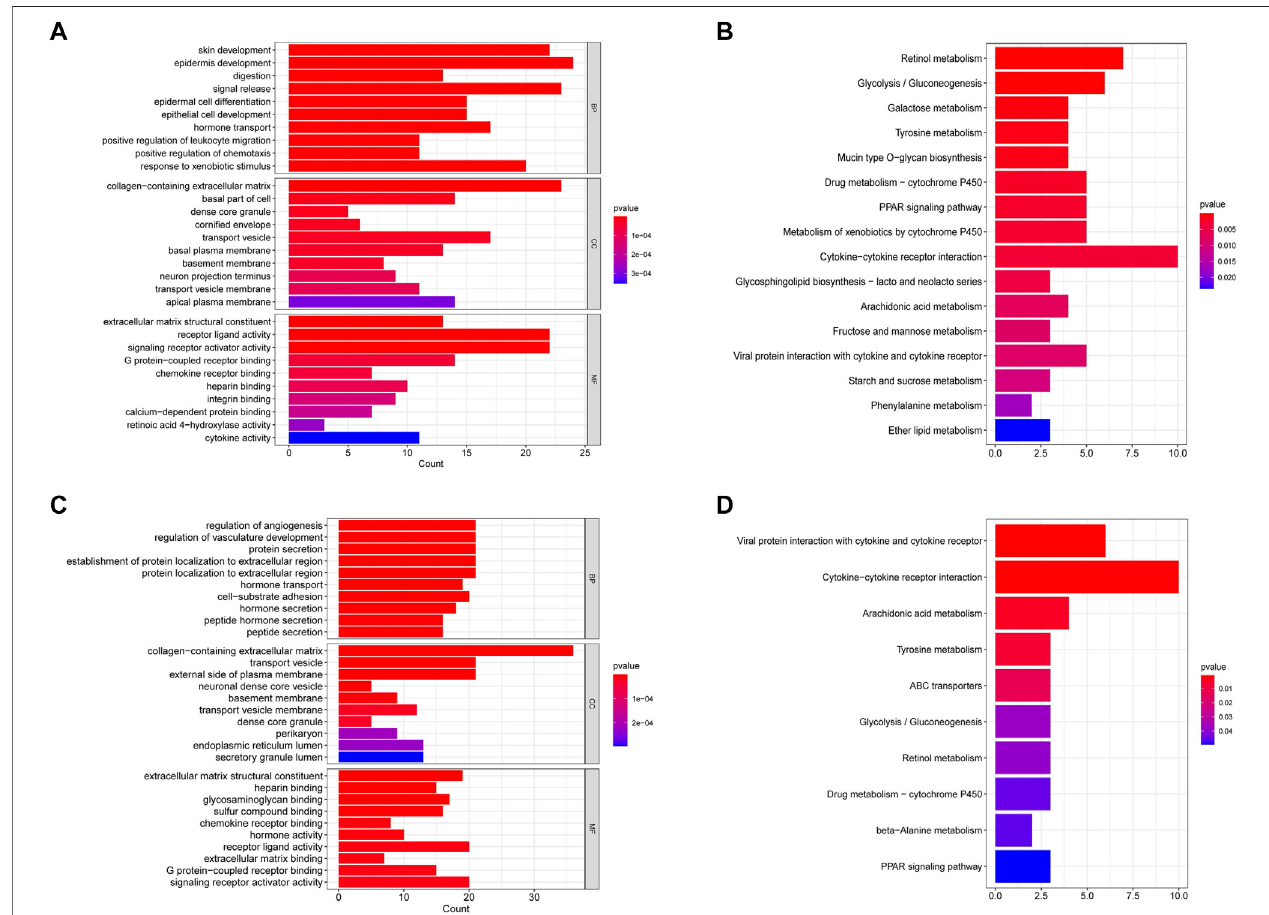
FIGURE8| Functional enrichmentanalysis ofdifferentially expressed genes inthe TCGA and GEOcohorts. (A) GOanalysisofdifferentially expressed genesin the TCGAcohort. (B) KEGG pathway analysisof differentially expressed genes in the TCGA cohort. (C) GO analysis ofdifferentially expressed genes in theGEOcohort. (D) KEGG pathway analysis of differentially expressed genes in the GEO